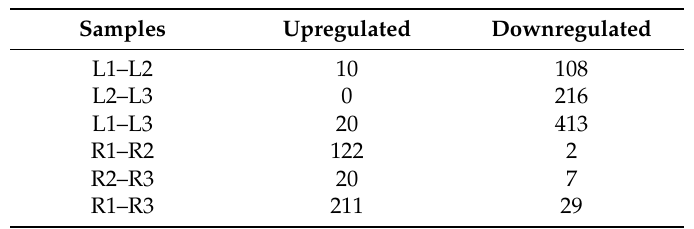
Table 1. Numbers of differently expressed proteins during drought stress. The “upregulated” row indicates the number of upregulated proteins in posterior samples compared with anterior samples. The “downregulated” row indicates the number of downregulated proteins in posterior samples compared with anterior